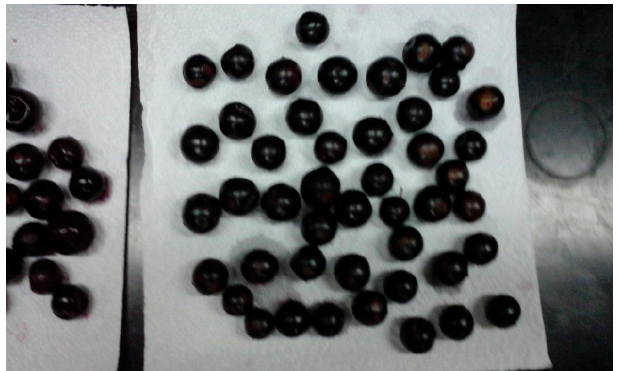
Figure 1. Fruit of Plinea peruviana.